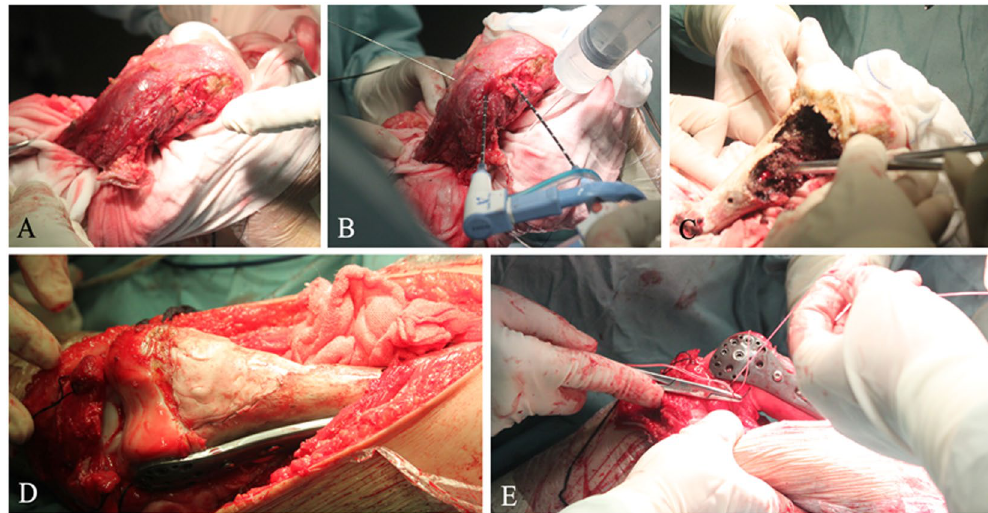
Figure 4. Surgical procedure. ( A ) Bone tumor was separated from the surrounding normal tissues with an adequate margin. ( B ) Microwave ablation of the tumor tissue was performed in situ . ( C ) The ablated tumor tissue was removed. ( D ) The resultant bone defect was filled with the mixture of allograft bone and cement, followed by the fixation with the personalized titanium plate. ( E ) The lateral collateral ligaments were sutured to the lateral